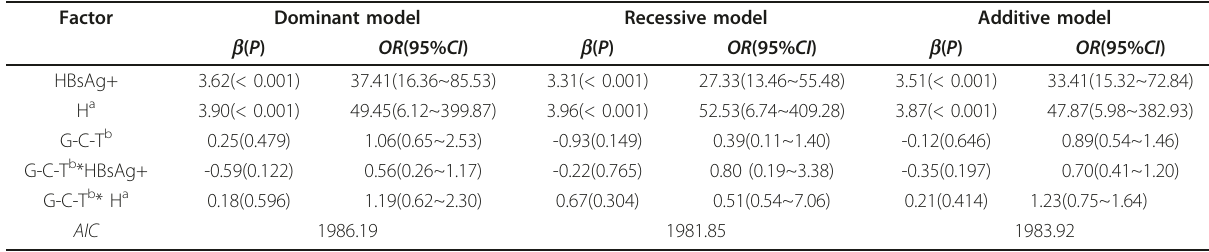
Table 7 Analysis of haplotype-envioronment interactions under different genetic models Factor Dominant model Recessive model Additive